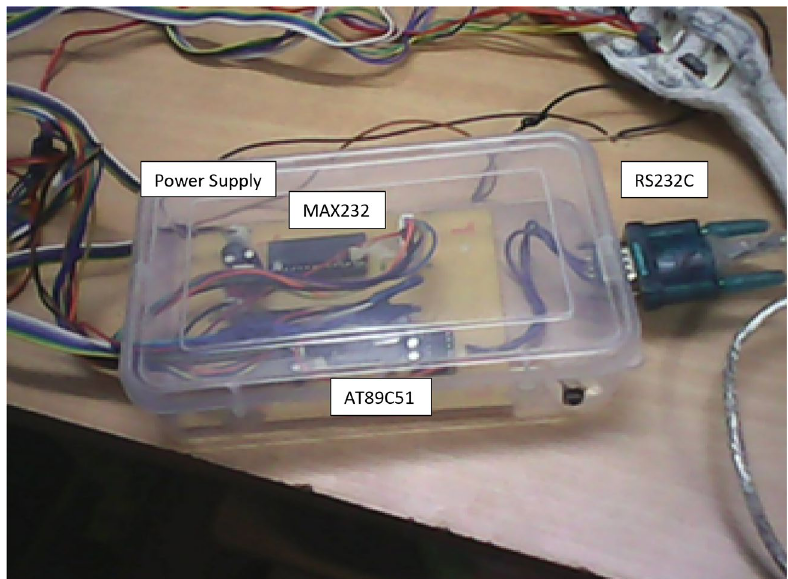
Figure 3. Switching and signal processing